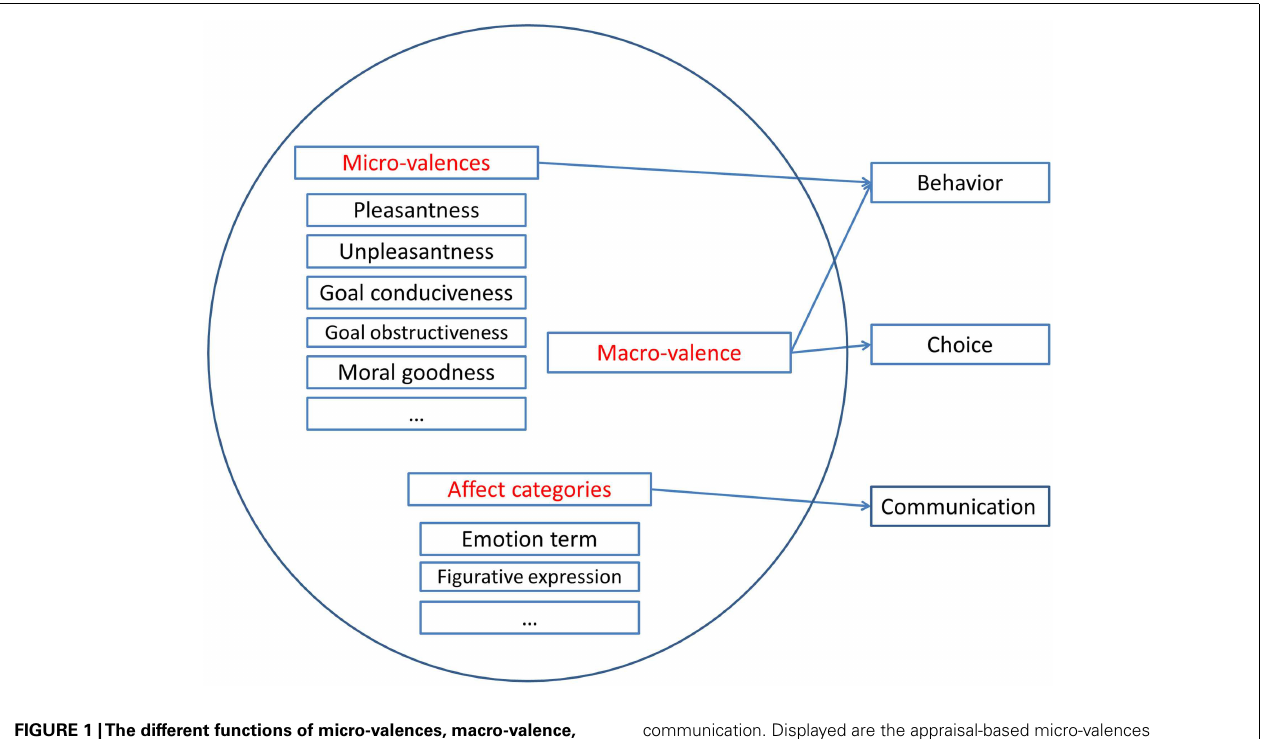
FIGURE 1 |The different functions of micro-valences, macro-valence, and affect categories. Various micro-valences (individual evaluations, positive and negative dimensions), macro-valence (an overall affect ranging from negative to positive), and affect categorization co-occur in time. Micro-valences and macro-valence influence behavior, macro-valence is necessary for choice, and affect categories are used in